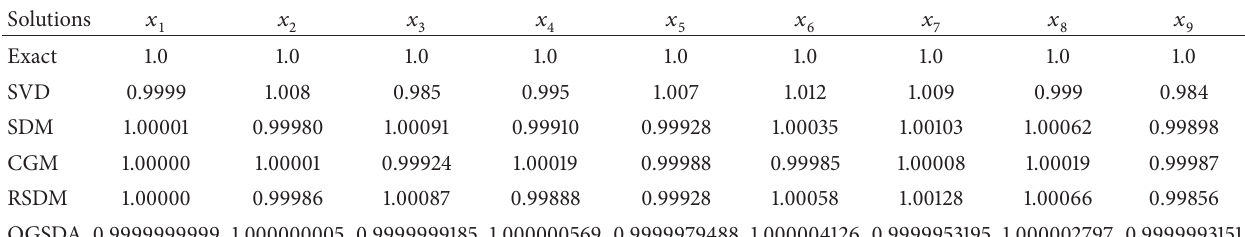
Table 1: Comparing the numerical results for Example 2 with different methods.